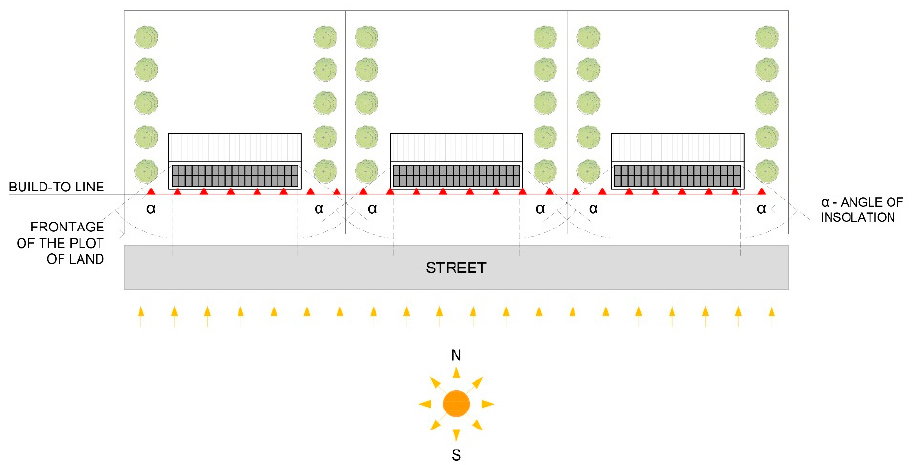
Figure 5. Predictable positions of buildings and PV panels because of a compulsory built-to line defined in the zoning plan (diagram by W. Celadyn, P. Filipek).